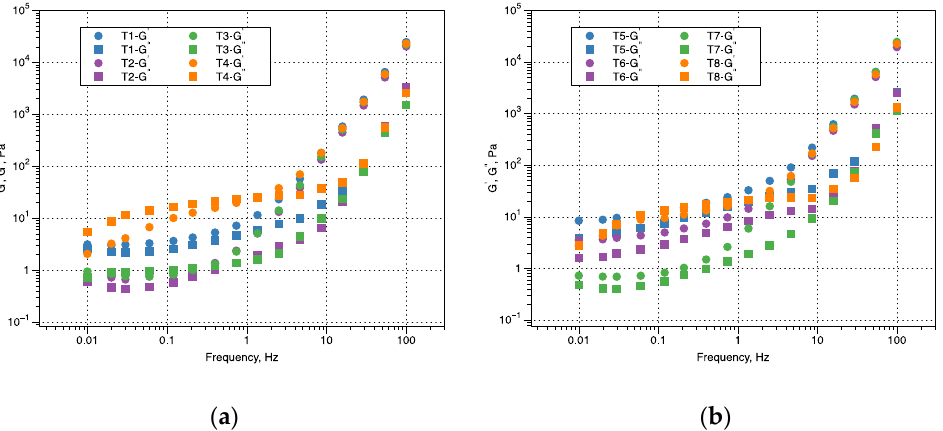
Figure 2. The storage ( G ’) loss ( G ”) modulus as a function of frequency of vanilla flavored ice cream mixes. ( a ) (Concentration 0.4%, T1 (20:80 mucilage:CMC), T2 (50:50 mucilage:CMC), T3 (80:20 mucilage:CMC), and T4 (100: 0 mucilage:CMC)), ( b ) (Concentration 0.8%, T5 (20:80 mucilage:CMC),